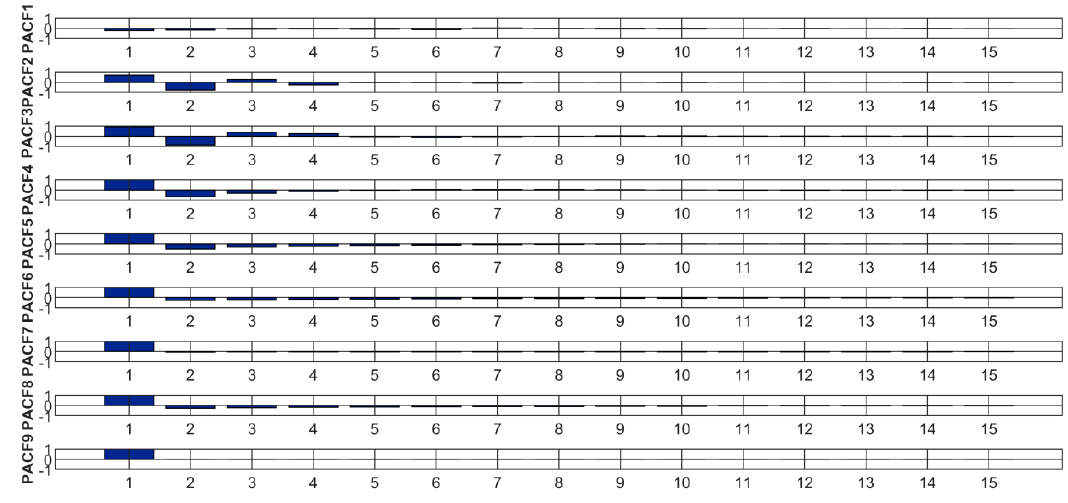
Figure 9. The PCAF results of the Hubei carbon price after EMD.